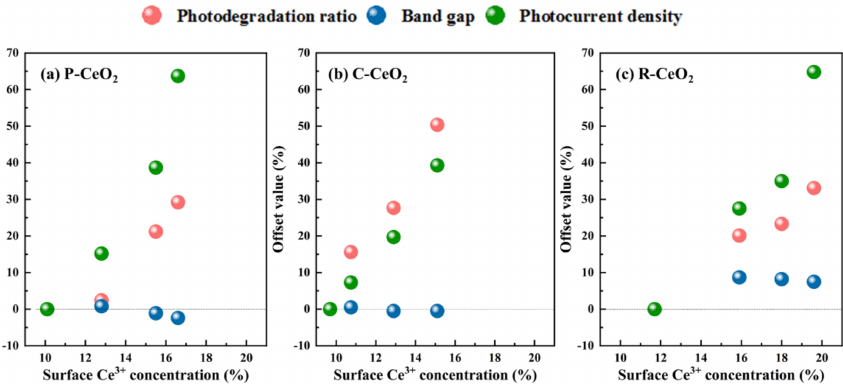
Figure 10. The contributions of Ce 3+ on the photoelectric characterizations and photocatalytic activity.